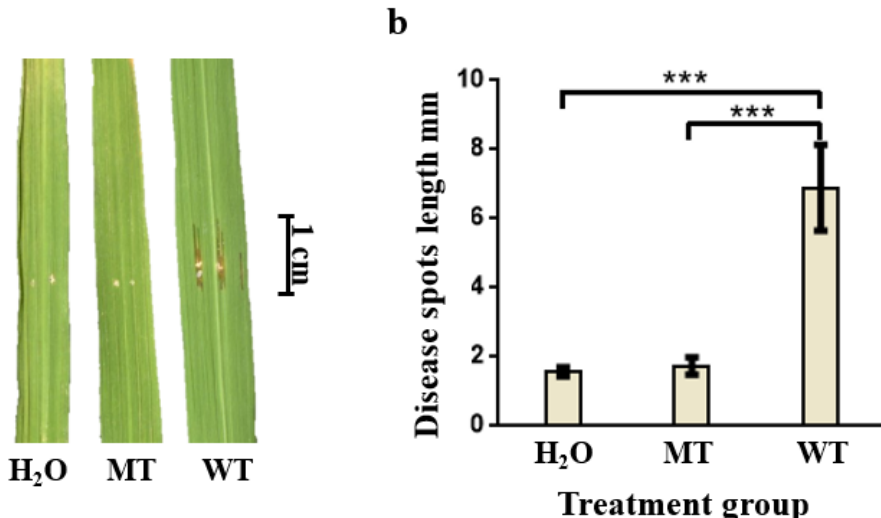
Figure 1. Investigation results of spots of WT, MT and H 2 O in three inoculation treatment groups. ( a ) Comparative phenotype of NIL- bls2 leaves in three treatment groups. ( b ) Comparison of lesion lengths of WT, MT and H 2 O in inoculation groups. The correlation coefficients (Mean, SD and number) were H 2 O (1.54 mm, 0.14, 6), MT (1.72 mm, 0.26, 6), WT (6.87 mm, 1.24, 6). *** represents p < 0.001.